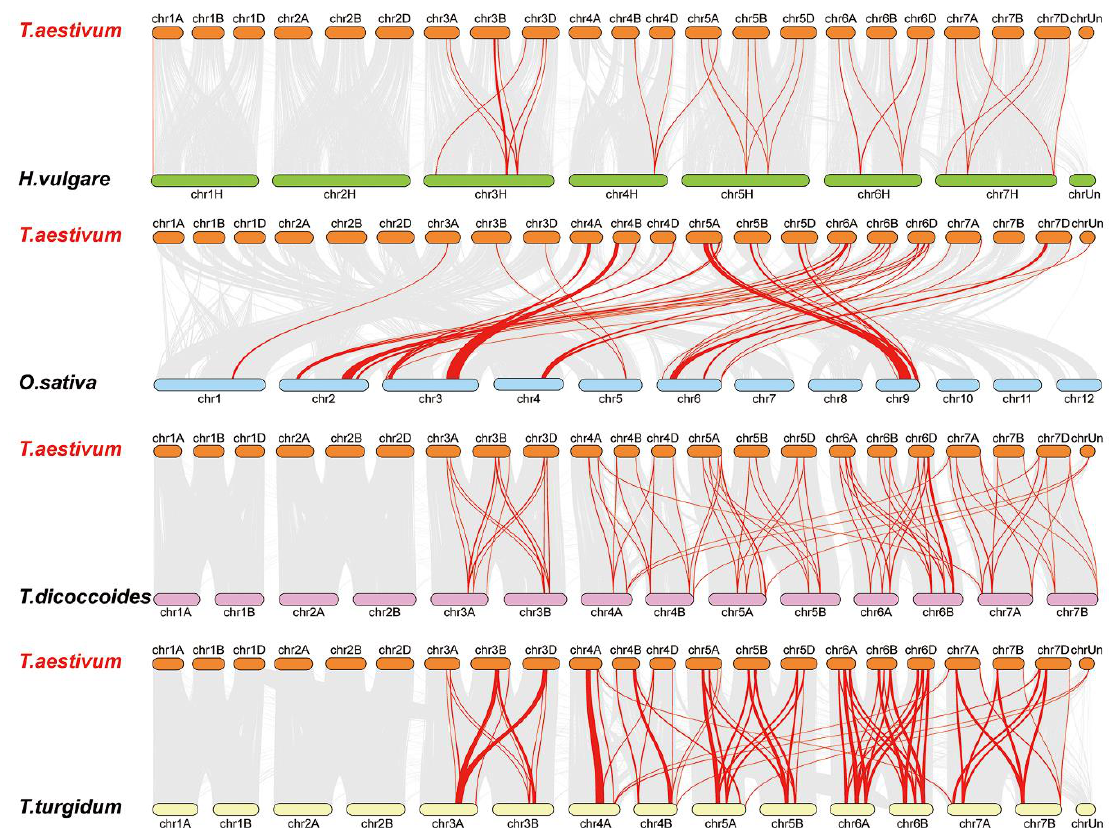
Figure 6. Synteny analysis of the LysM family. Red lines are the syntenic LYP and LYK gene pairs for different species. Gray lines are collinear blocks for plant genomes. The species are Triticum aestivum , Hordeum vulgare , Oryza sativa , Triticum dicoccoides , and Triticum turgidum .